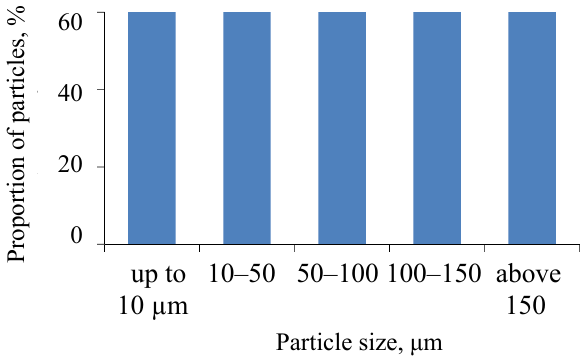
Fig. 6. Distribution of particle sizes of carrot pulp after